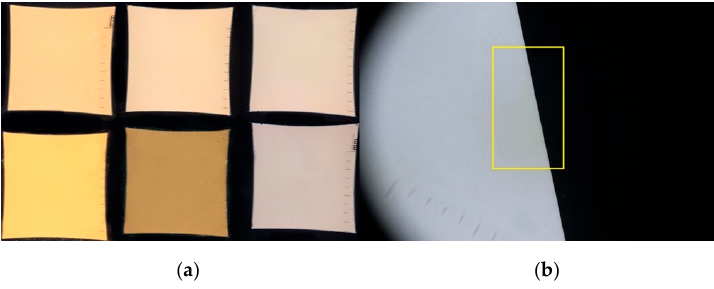
Figure 3. ( a ) Colours of six patches represent human reference skin colours. ( b ) A slanted edge micro-test chart as applied when sharpness is measured from the target.